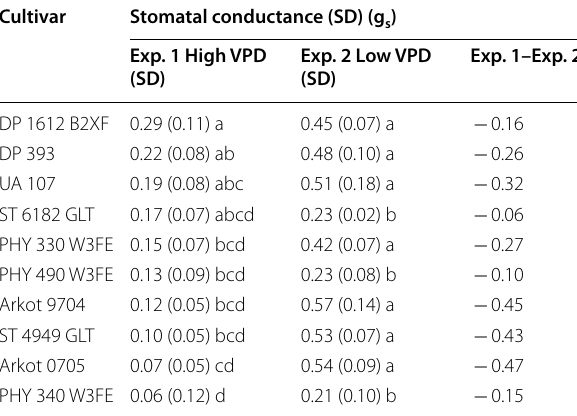
Table 2 Stomatal conductance (g and standard deviation (SD) for cultivars from Experiment